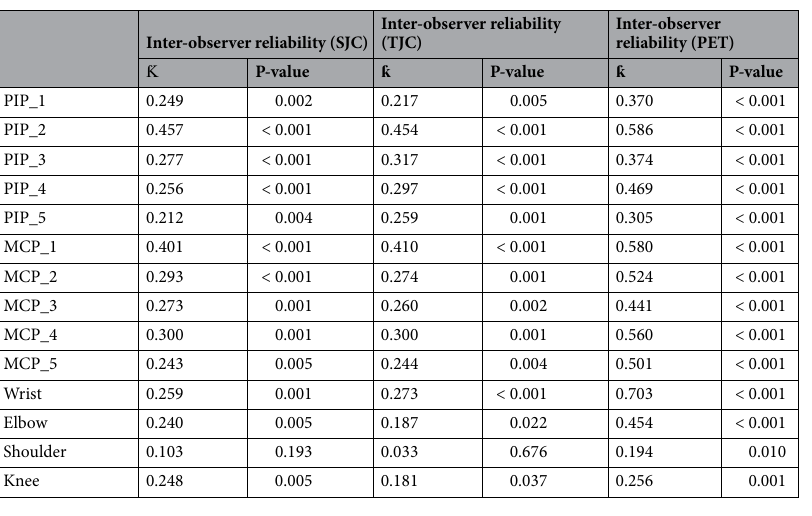
Table 2. Reliability between bone scintigraphy and other disease activity measures for joint counts Inter- observer reliability was calculated using the Cohen κ-test and intraclass correlation coefficients (ICC). For the SJC and the TJC, the ICC was 0.585 (95% CI 0.324–0.745) and 0.646 (95% CI 0.424–0.783), respectively. For the PET, the ICC was 0.782 (95% CI 0.646–0.866). SJC swollen joint counts, TJC tender joint counts, PIP proximal interphalangeal joint, MCP metacarpophalangeal joint, CI confidence